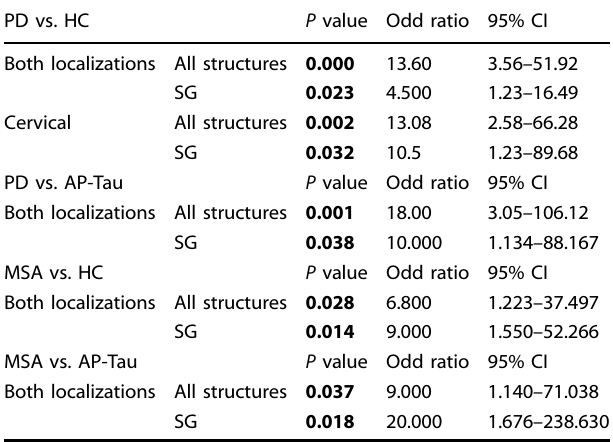
Table 2. Association between α Syn-PLA detection and clinical